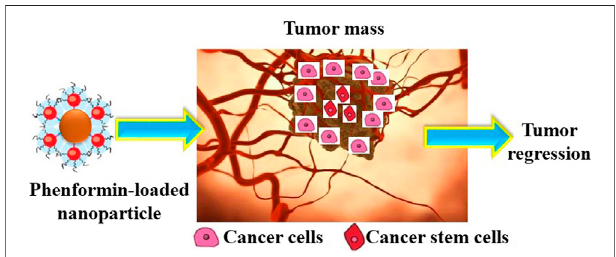
FIGURE 4 | Schematic mechanism for the drug delivery by Fe